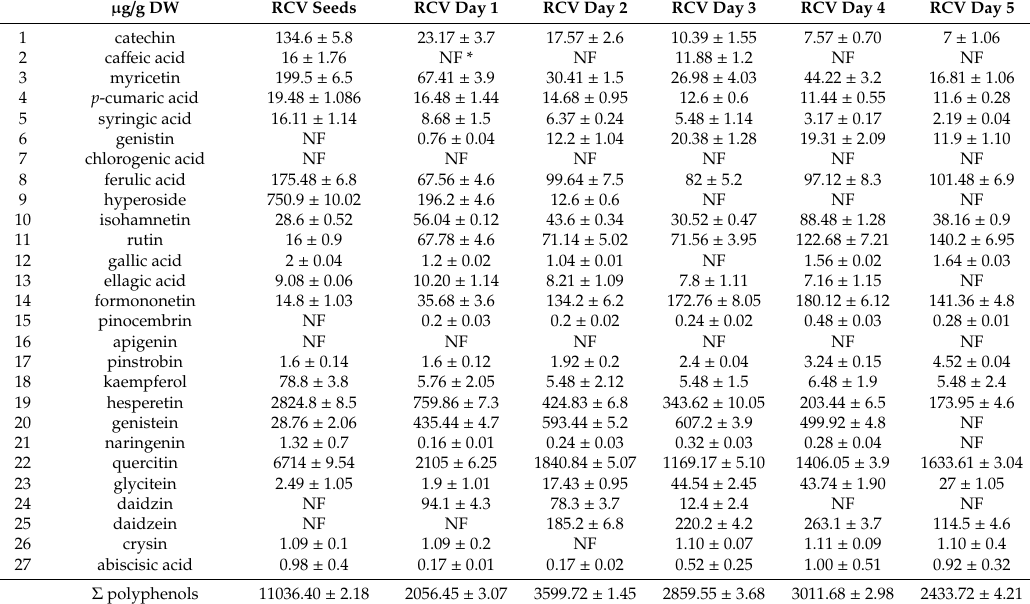
Table 6. The results of the quantitative analysis for red clover sprouts in µ g per g of dried weight (DW) vegetal material (red clover sprouts samples coded as: RCV - red clover, day 1-first day of germination, day 2-second day of germination, day 3-third day of germination, day 4-fourth day of germination, day 5-fith day of